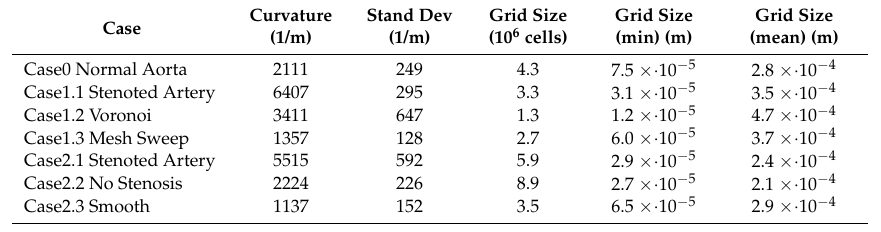
Figure 2. Case1 segmentations: original ( a ), Voronoi ( b ) and mesh sweeped and smoothed ( c ).